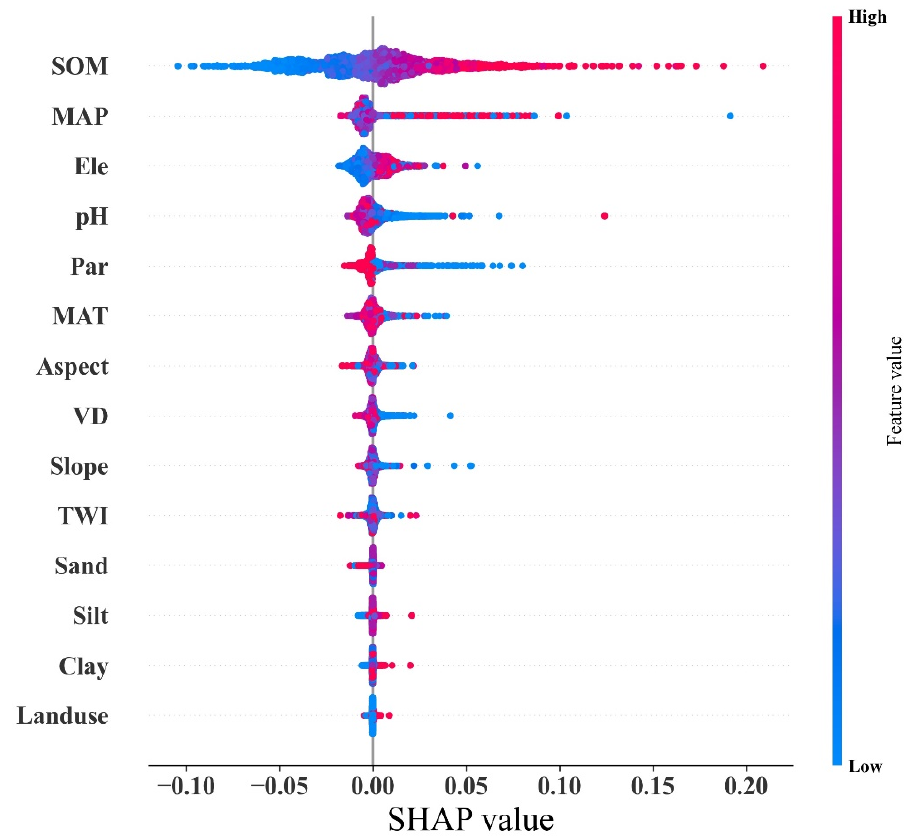
Figure 6. Shapley additive explanations (SHAP) summary plot of environmental factors for soil Se content. Environment factors are arranged along the Y ‐ axis according to their importance, with the most key factors ranked at the top. The color of the points represents the high (red) or low (blue) values of the environmental factor. Ele: elevation; Par: soil parent material.